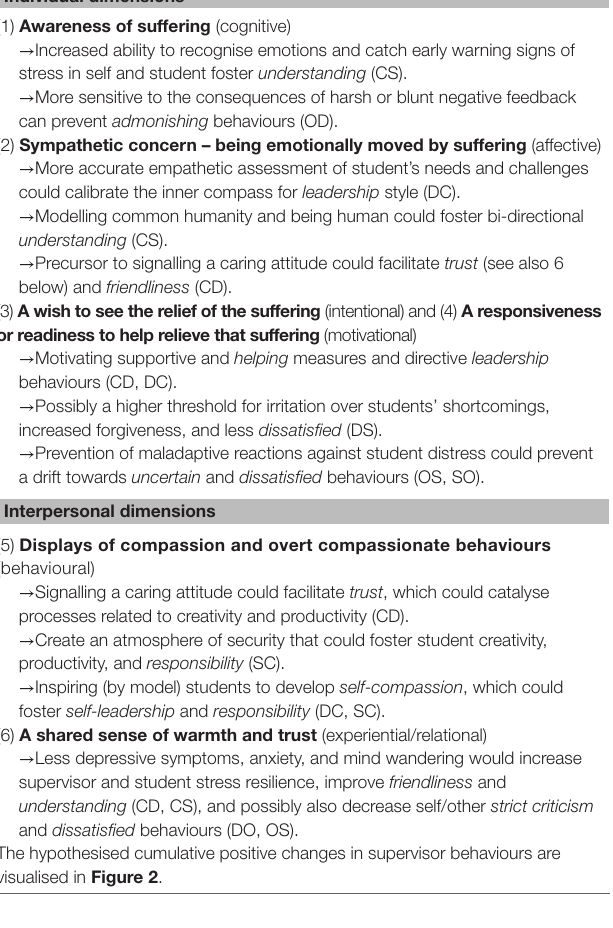
TABLE 1 | Analysis: the application of compassion onto a model for supervisor interpersonal behaviour. Individual